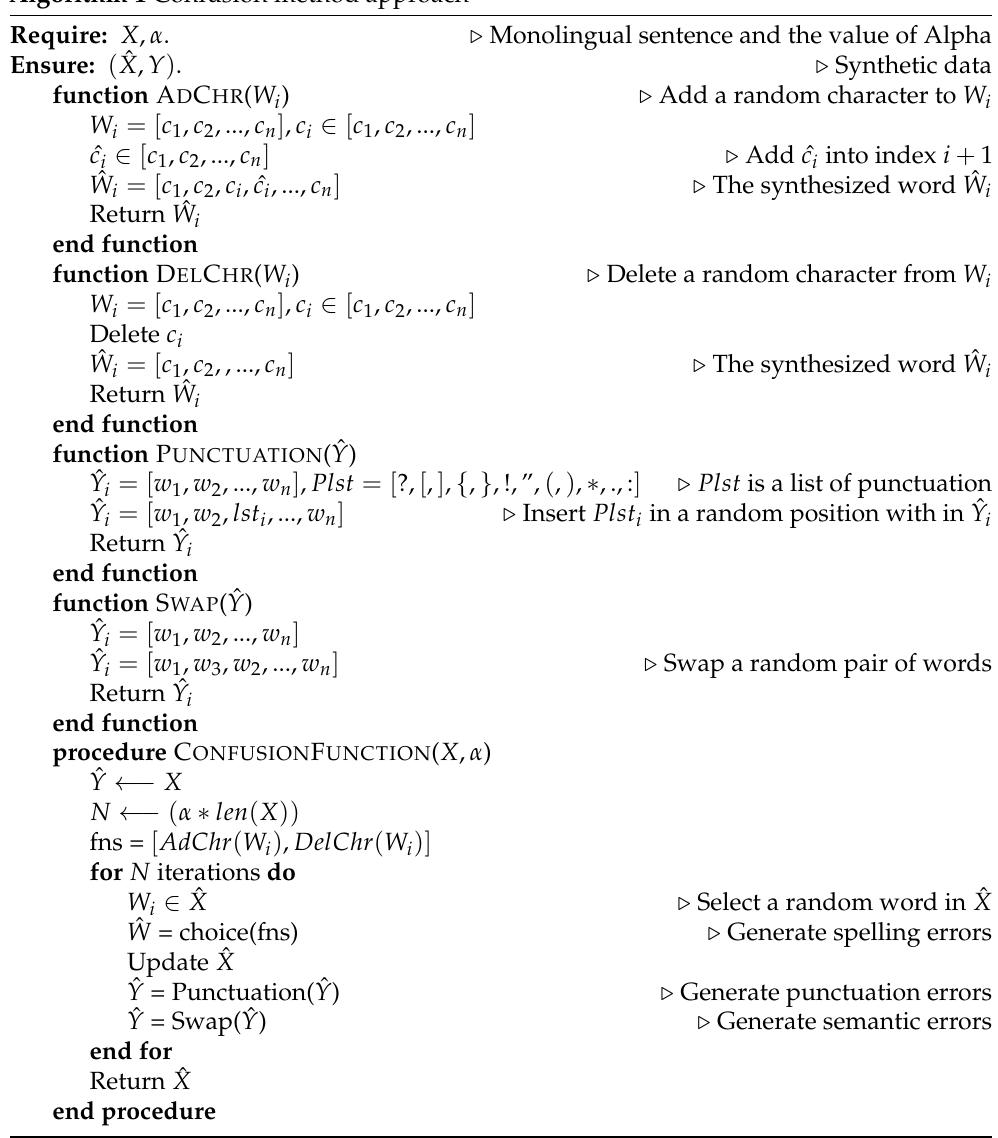
Figure 4. Illustration of a semi-supervised method. Algorithm 1 Confusion method